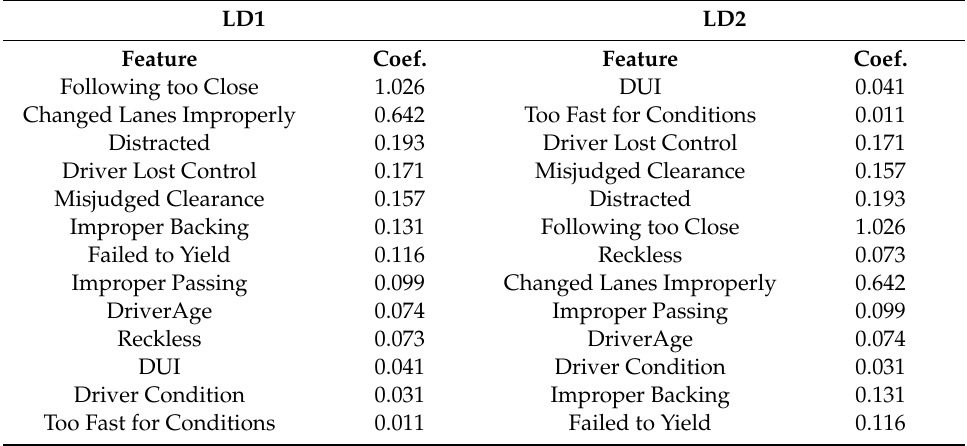
Table 6. Loading factors for driver-related features.